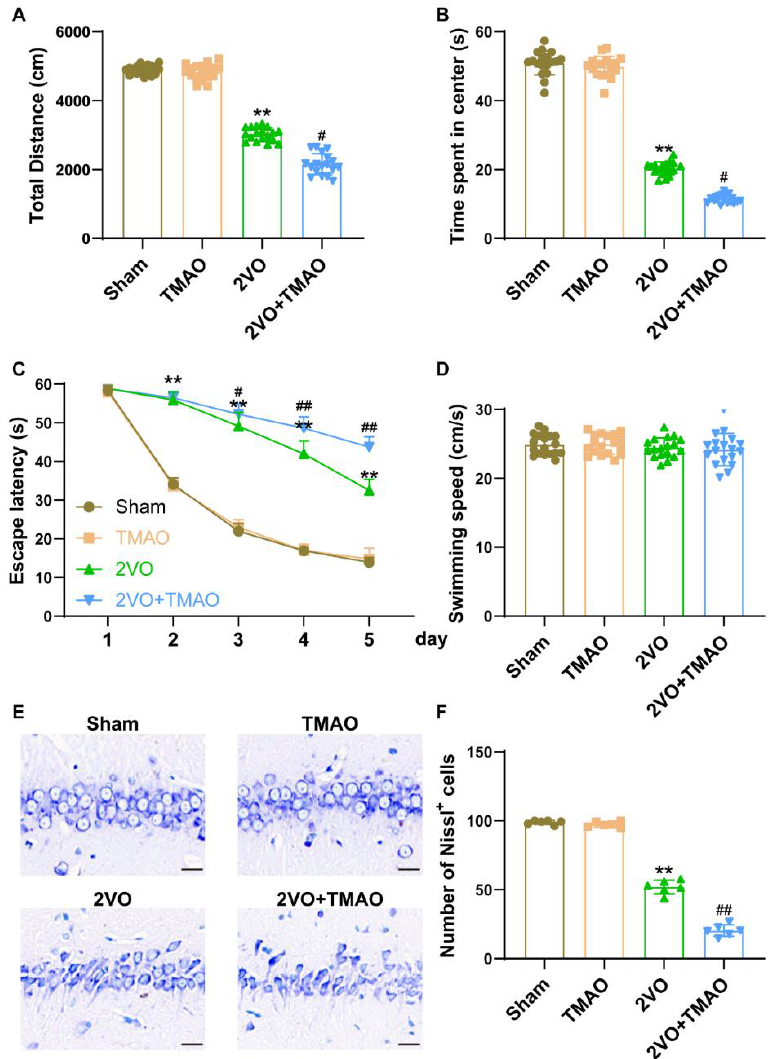
Figure 2. TMAO aggravated cognitive function deficits in 2VO rats. The ( A ) total distance traveled and ( B ) duration of time spent at the center across the groups were measured using an open field test (n = 18). The ( C ) escape latency and ( D ) swimming speeds across the groups were recorded during the hidden stage task of rats 4 weeks after 2VO surgery (n = 18). ( E ) Images reflecting neuronal injuries within the hippocampal CA1 area of the rats across the groups were detected via Nissl staining. Scale bar, 20 µ m (n = 6). ( F ) Quantification of the Nissl + cells is shown as a bar chart (n = 6). Datasets reflect the mean ± SD. ** p < 0.01 versus the Sham group; # p < 0.05 and ## p < 0.01 versus the 2VO